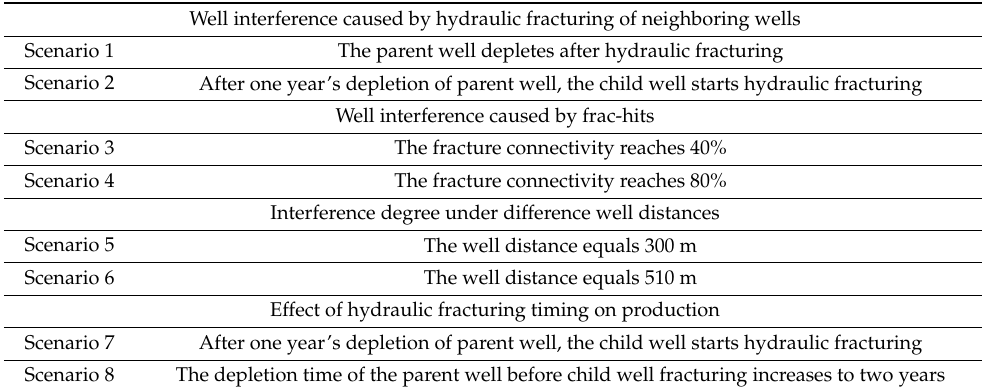
Table 2. The summary of the model setup of different scenarios.